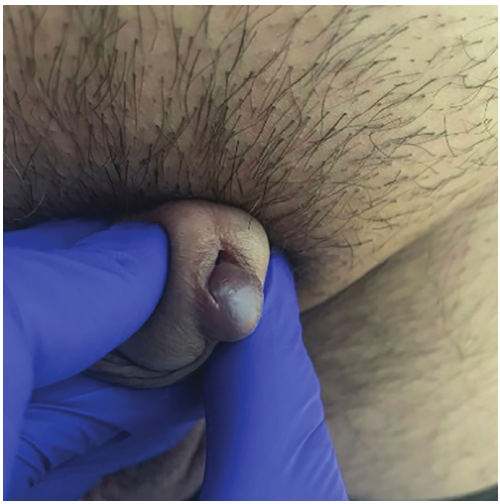
Figure 1 - Parameatal cyst